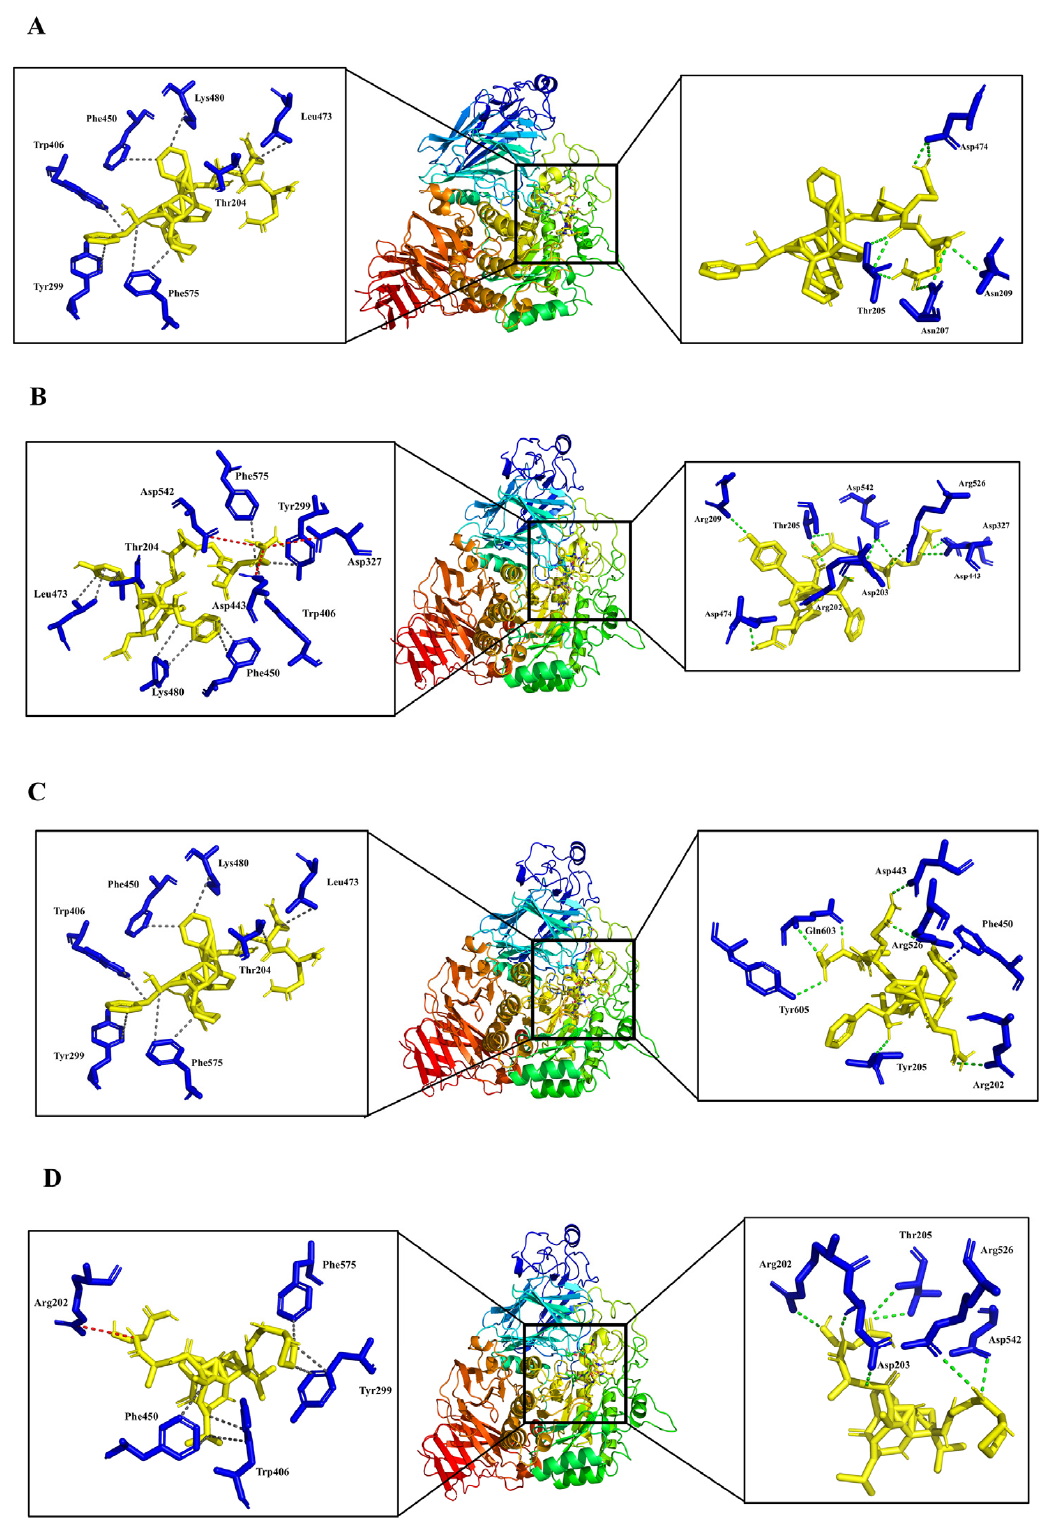
Figure 4. Docking results of peptides with α -glucosidase (( A ) FFVPPSQQ, ( B ) FYNPAAGR, ( C ) FSYN- PQAG, ( D ) PGVLPVAS). In the enlarged image, the yellow bar model represent polypeptides and the blue bar model represent amino acid residues. Green and grey dashed lines represent hydrogen bonding and hydrophobic interactions. Salt bridges and π -stacking are represented by red and blue dashed